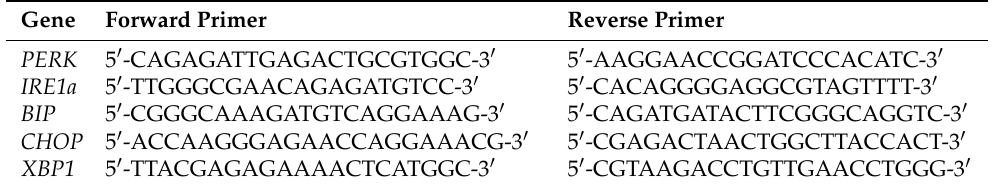
Table 1. List of primers used for the quantification of ER stress